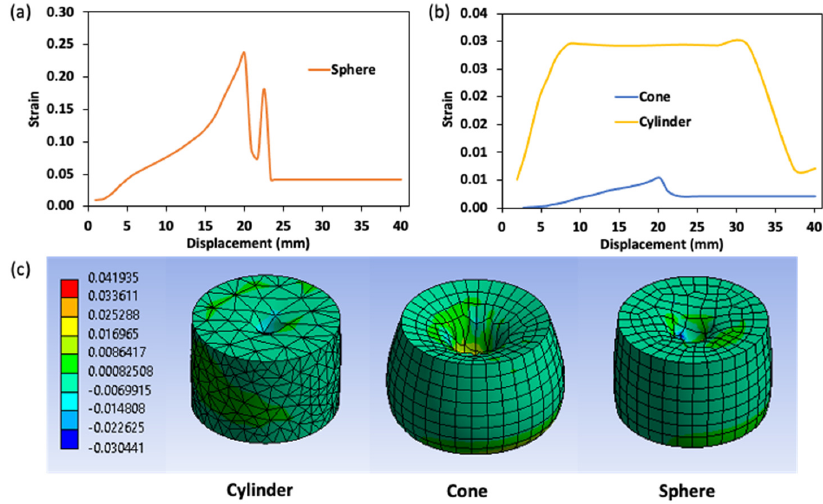
Figure 8. Strain curve of various penetration probes during puncture analysis for surimi gel; ( a , b ) quantitative strain value and ( c ) contour description of the strain distribution in a puncture gel at a depth of 20 mm.